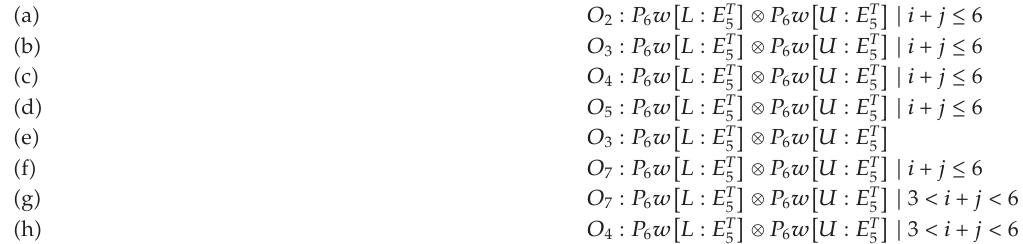
Table 2: Compact algebraic representation of graph products presented in Figure